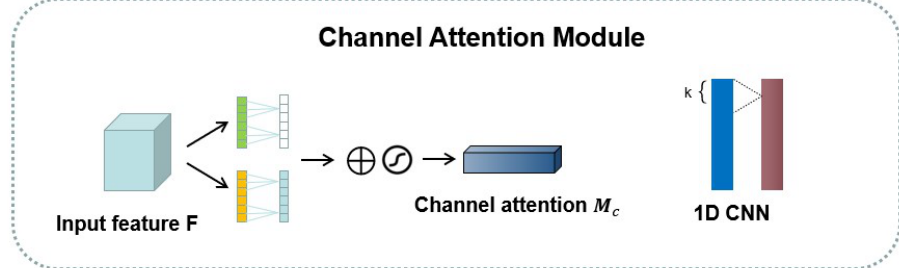
Figure 8. Improved CBAM channel attention mechanism model diagram.